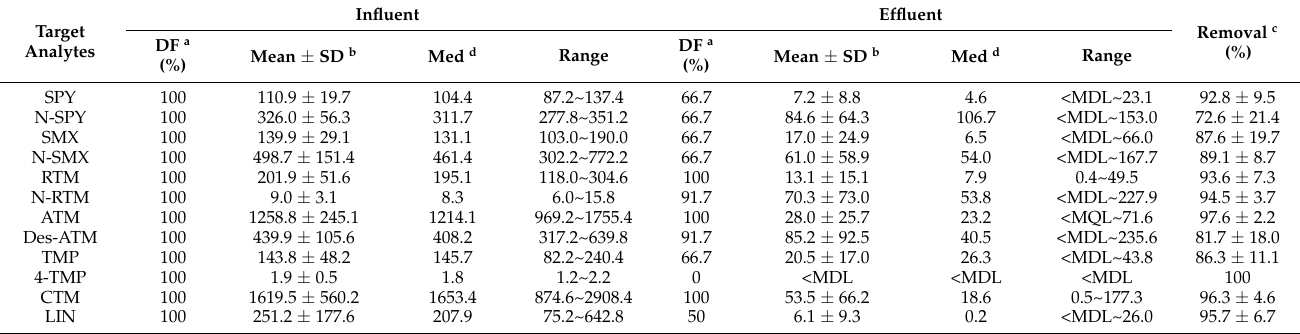
Table 4. Statistics of target analytes concentrations (ng/L) in Beijing WWTPs ( n = 24). Target